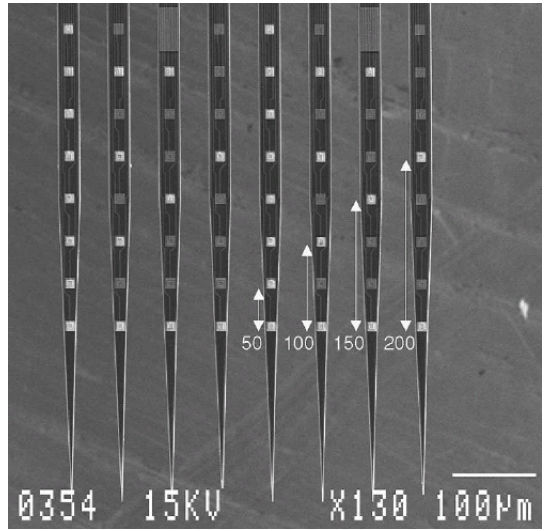
Figure 10. Scanning electron micrograph showing selectively opened electrode windows N layer on a 64-site probe. Bright squares are opened windows. Distances shown in the Si 3 4 are in micrometers. Reprinted from [105], with permission from